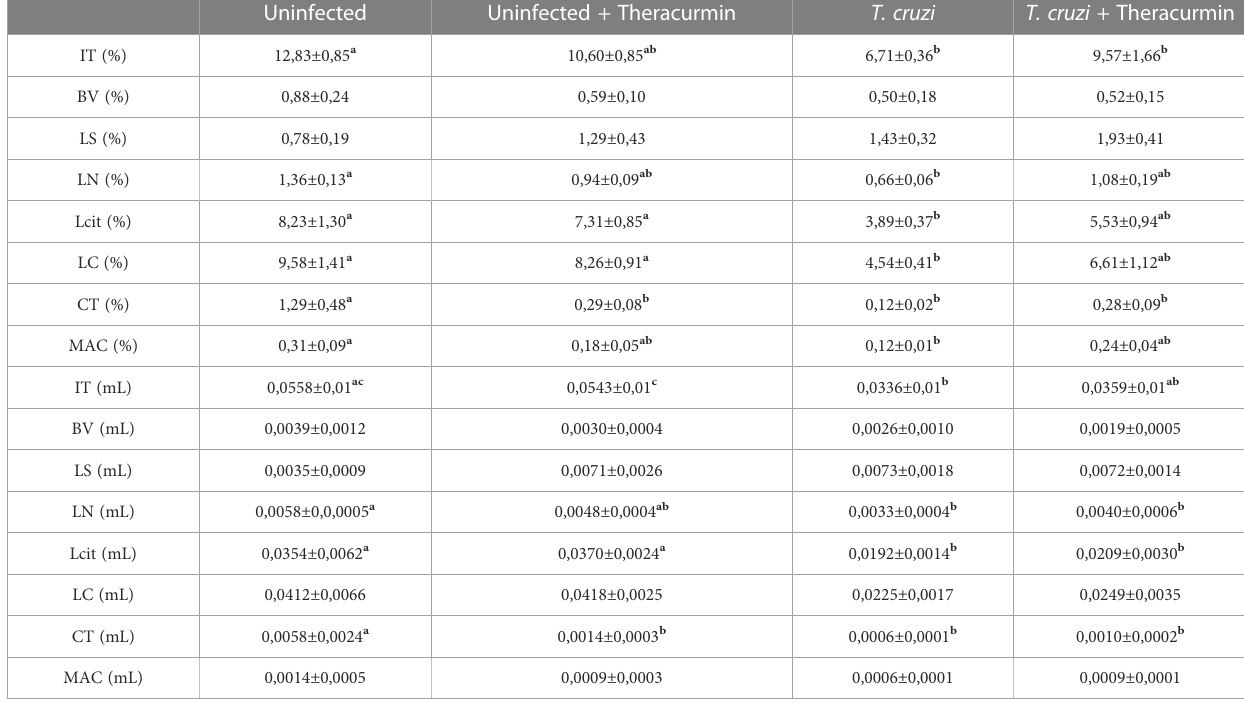
TABLE 4 Percentage and volume of the intertubular components in mice infected with T. cruzi and treated with Theracurmin.